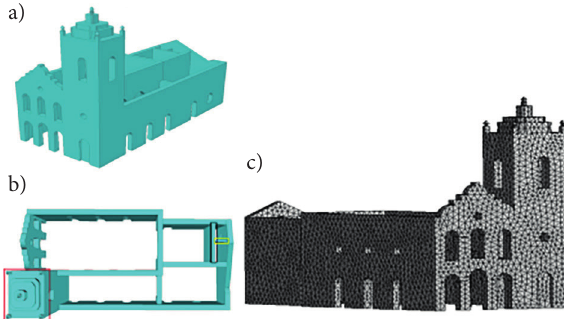
Fig. 7. 3D finite element model of the Nossa Senhora das Dores Church: a) lateral view of 3D model; b) top view of the 3D model and c) 3D model with finite element